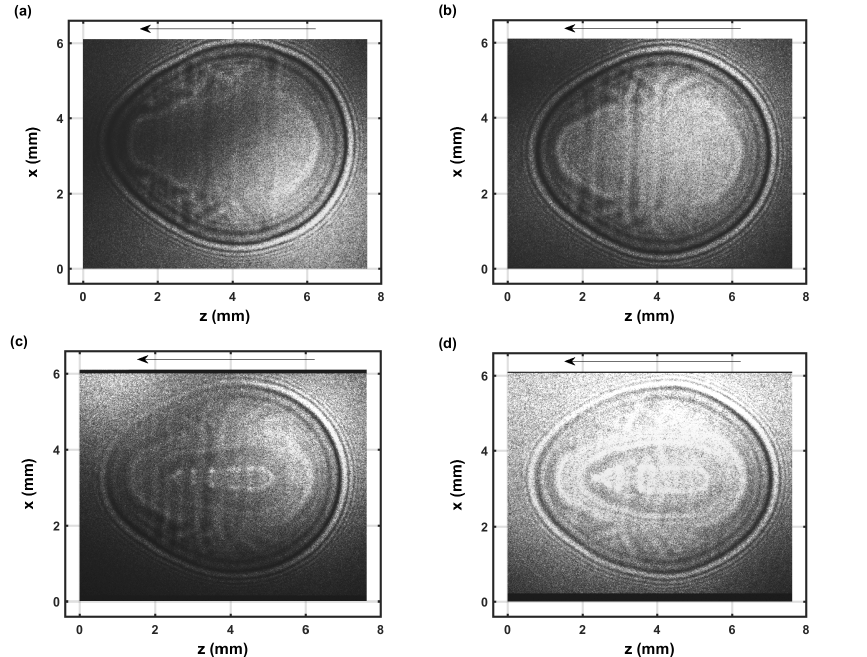
Figure 5. Single-shot shadow graph of the expanding laser-induced plasma initiated with a 170-mJ, 6-ns, 1064-nm focused beam, and imaged using a 5-ns, 532-nm back-light that shows intensity variations and is time-delayed by 1.15 µ s ( a , b ). Double exposure images for time delays of 1 µ s and 0.1 µ s ( c , d